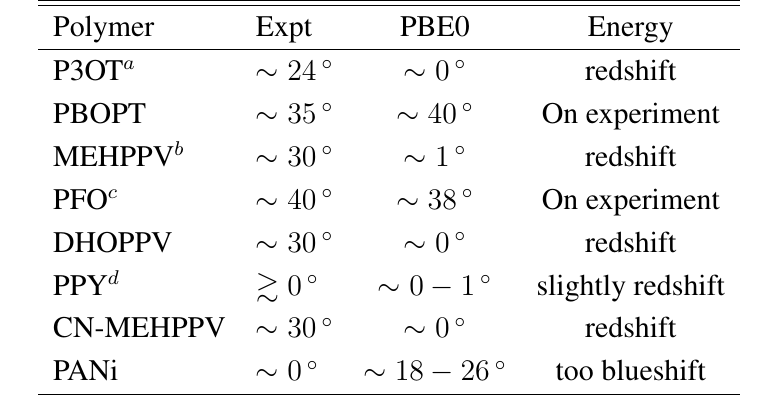
Table 20. Torsions of the conjugated polymers.